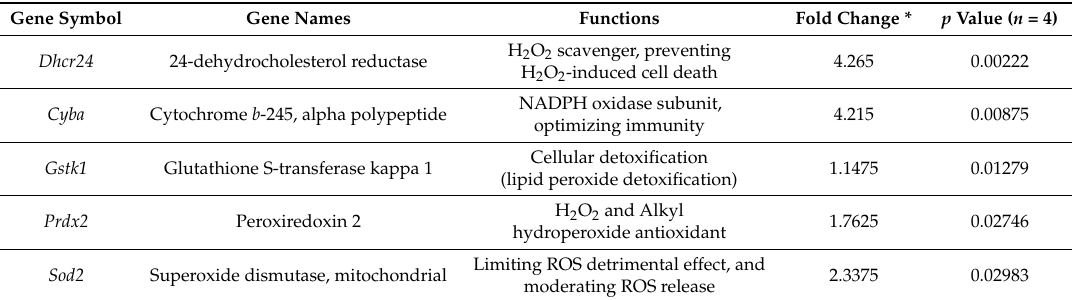
Table 2. Significant changes of oxidative stress-related gene expression in renal cortex of WGP-fed rats as compared to Vehicle controls, analyzed using PCR